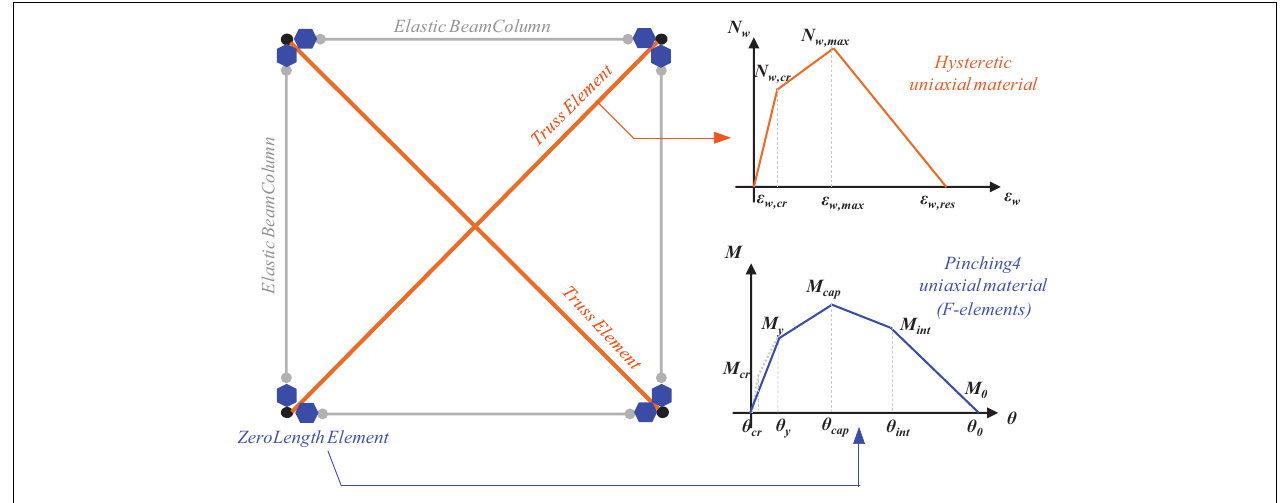
FIGURE 4 | Overview of the adopted modeling strategy for each building’s